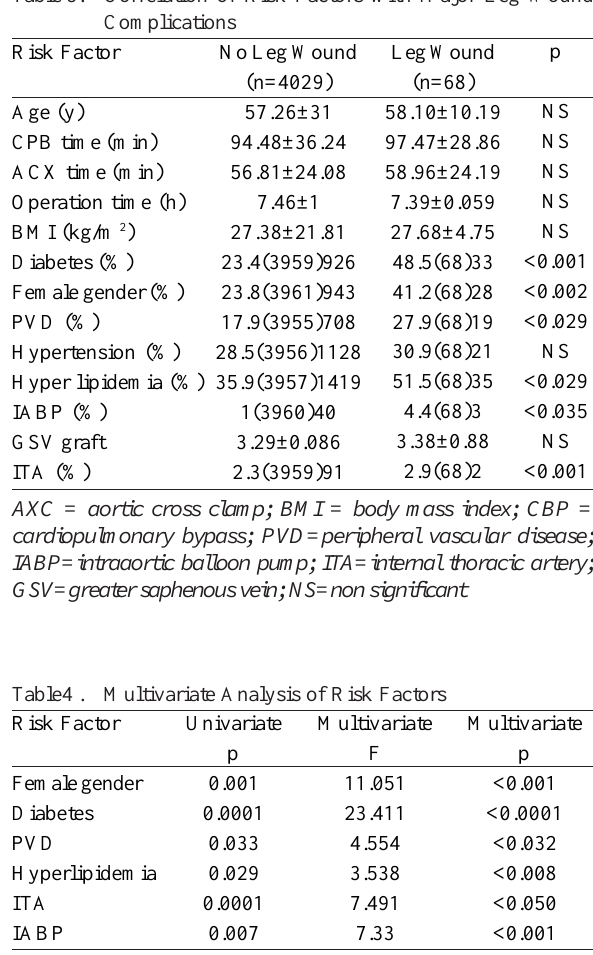
Table 3. Correlation of Risk Factors with Major Leg Wound